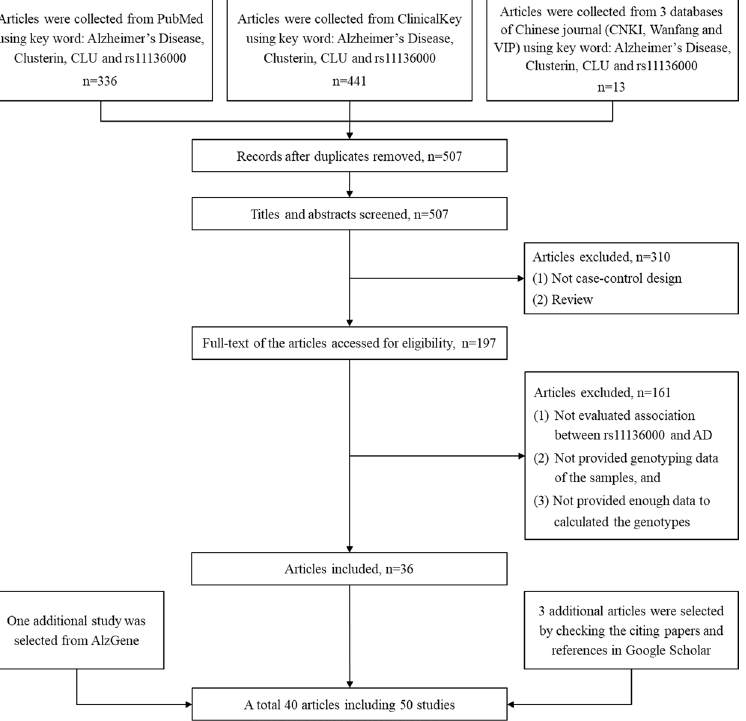
Figure 1. Flow chart of selecting studies for analyzing the association between rs11136000 polymorphism and